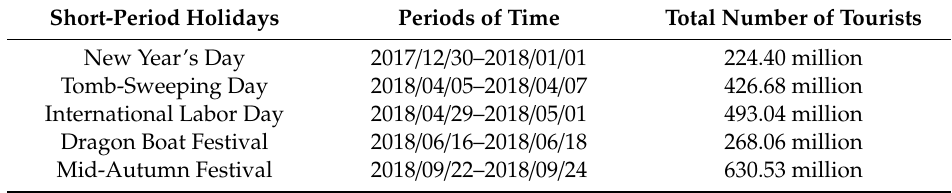
Table 1. Data description of tourist flow data.